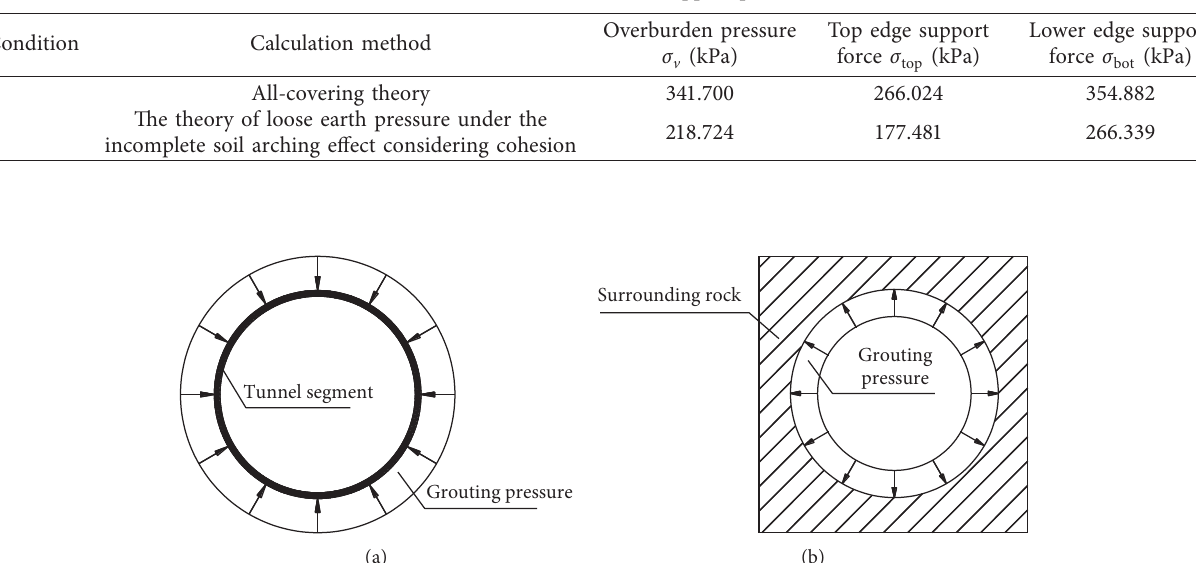
Figure 6: Sketch of support pressure. Table 2: Calculation table of support pressure.